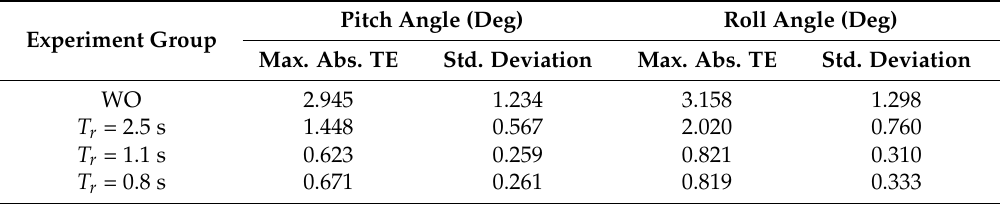
Figure 11. The attitude regulation performances of the pitch and roll angles with different T r : ( a ) the body pitch angle comparison and ( b ) the body roll angle comparison. Table 3. The attitude regulation results of WT with different T r